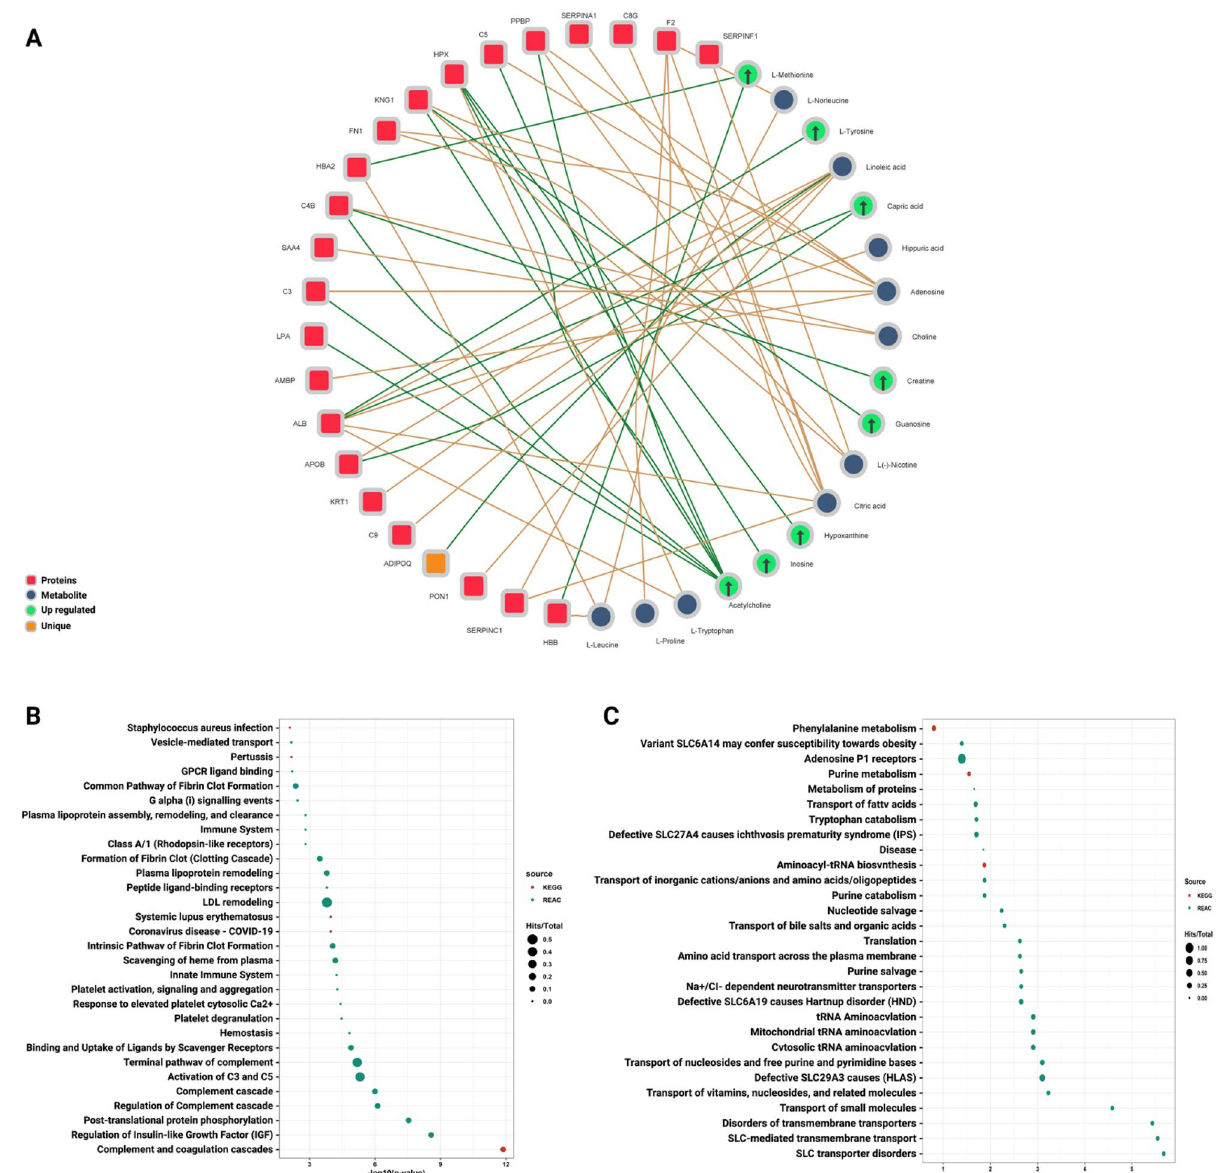
Figure 2. Knowledge-based interactions between plasma proteins and metabolites. The knowledge-based network generated by MetaboAnalyst and visualized by Cytoscape. ( A ) The network shows the metabolite- protein interactions across both omics The network contained 14 proteins, 18 metabolites, and 48 protein- metabolite interactions. Proteins are labelled in red and metabolites in blue. Upregulated and unique molecules are tagged in green and orange, respectively. ( B , C ) Pathway enrichment analyses applied on the knowledge- based network and retrieved from KEGG (red) and Reactome (green) databases. The circle size reflects the identified hits in this pathway divided by the total entities and the x-axis is the –log10 of the